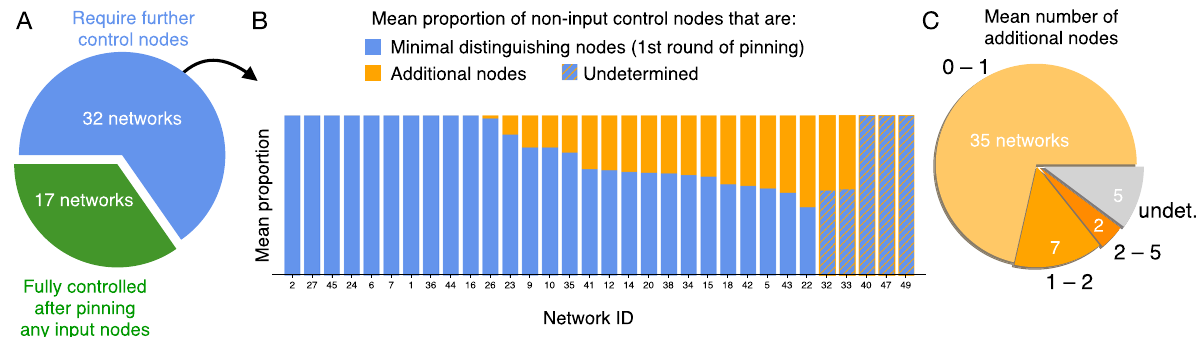
Fig. 4 Relative contributions of the successive rounds of pinning. After accounting for input nodes, minimal distinguishing node sets w (1) account for much of the size of control kernels in the 49 biological networks. A Some networks are fully controlled after pinning only input nodes, but most require further pinning. B Vertical bars indicate the mean proportion of non-input control nodes that correspond to minimal distinguishing nodes (blue) and those that must be set by additional pinning (orange). Network IDs correspond to those listed in Table 1. Some cases remain “ undetermined ” as identifying the minimal size of distinguishing node sets can be computationally infeasible (see “ Methods ” ). C In most networks, the mean number of additional nodes needed beyond the minimal distinguishing nodes remains